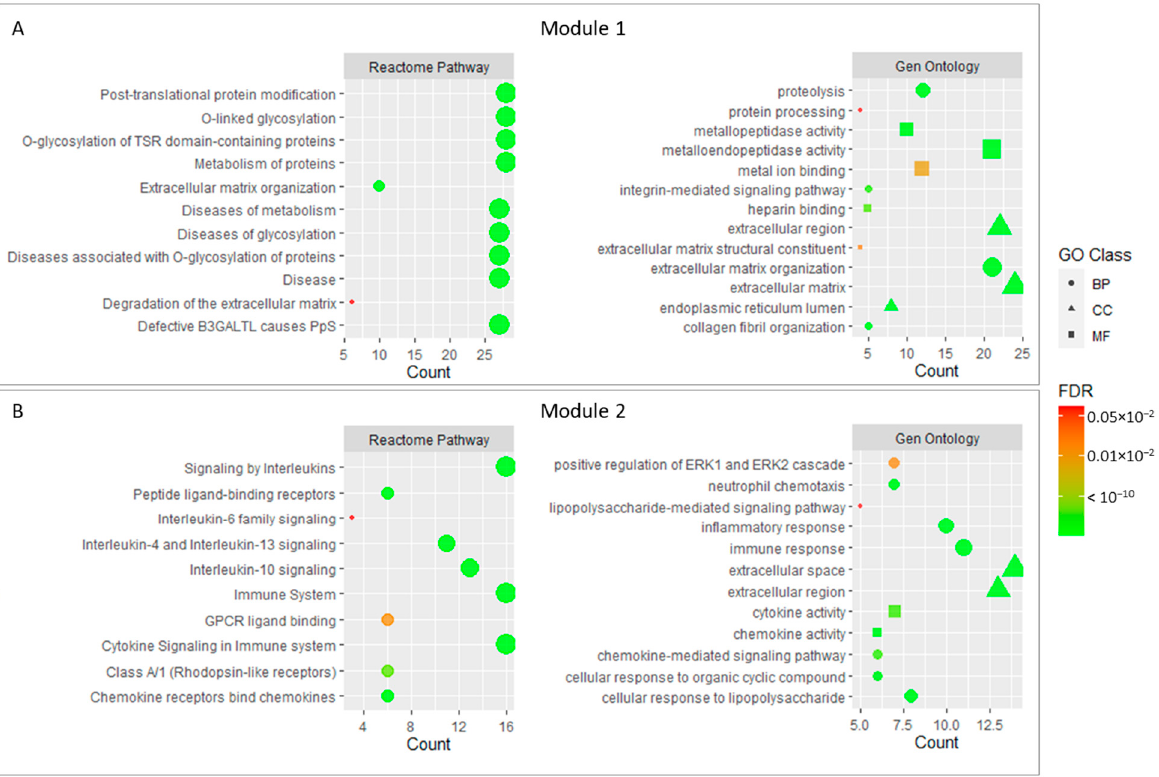
Figure 3. Main enrichment results of module 1 ( A ) and module 2 ( B ). The size of dots corresponds to the number of genes while the color of dots denotes the False Discovery Rate (FDR) value. The shapes of the dots in the Gene Ontology enrichment refer to Biological Process (BP), Molecular Function (MF), and Cellular Component (CC).